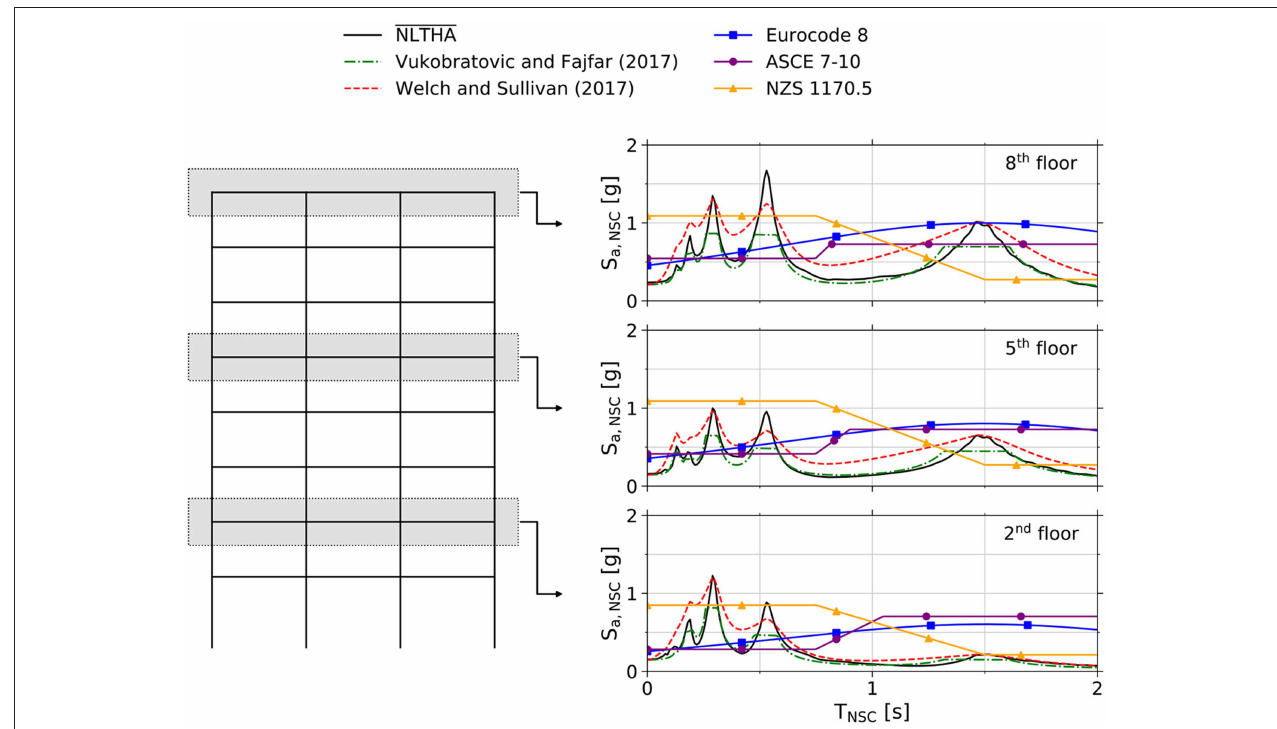
FIGURE 12 | FRS for an 8-story MRF (building config. 1) with targeted elastic ductility